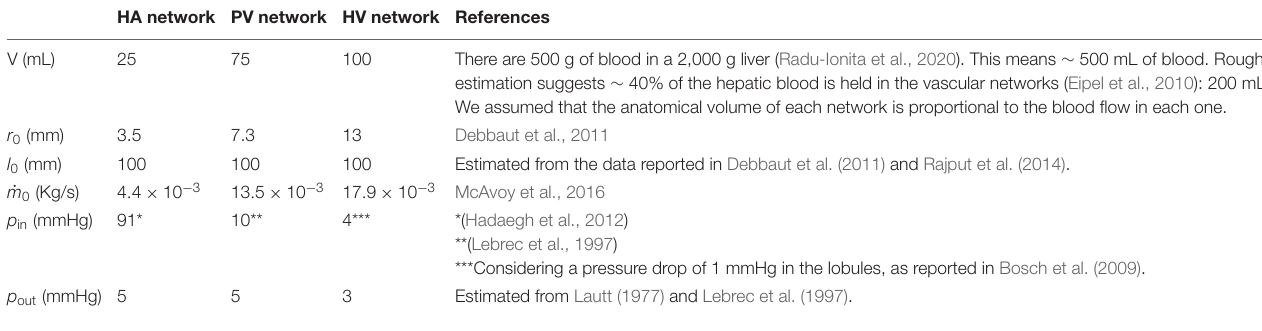
TABLE 1 | Parameters used for a healthy liver networks in the model. HA network PV network HV network